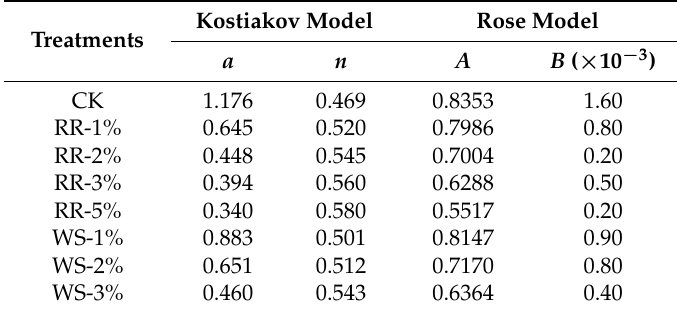
Table 3. Parameters in Kostiakov and Rose models for different